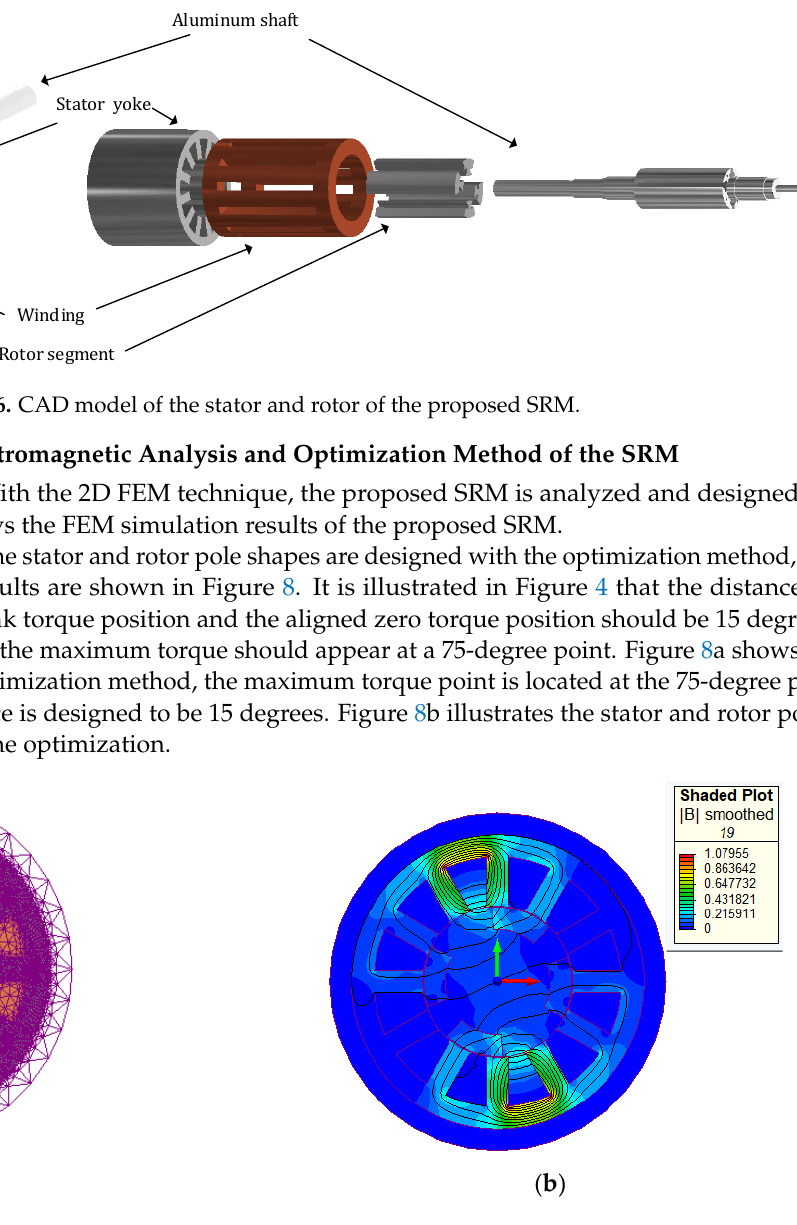
Figure 7. FEM simulation results of the proposed SRM: ( a ) the mesh distribution; ( b ) the magnitude of the magnetic flux density.